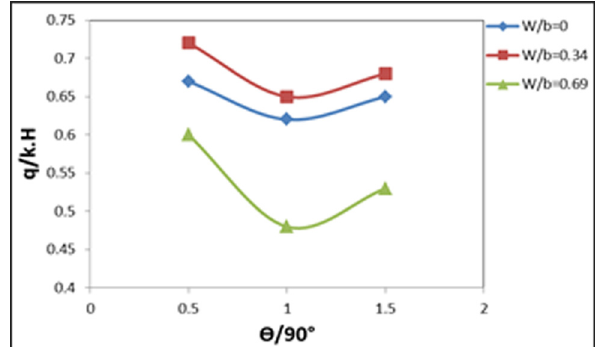
Figure 5: E ff ect of cuto ff angle on leakage for di ff erent width ratios W / b